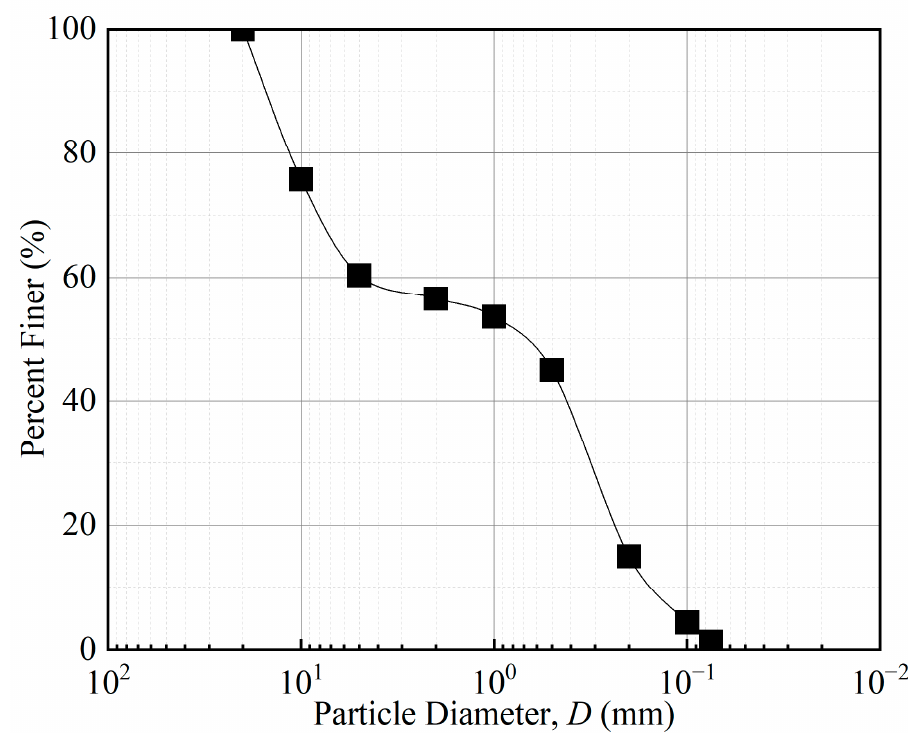
Figure 2. Particle size distribution curve of shield residues.